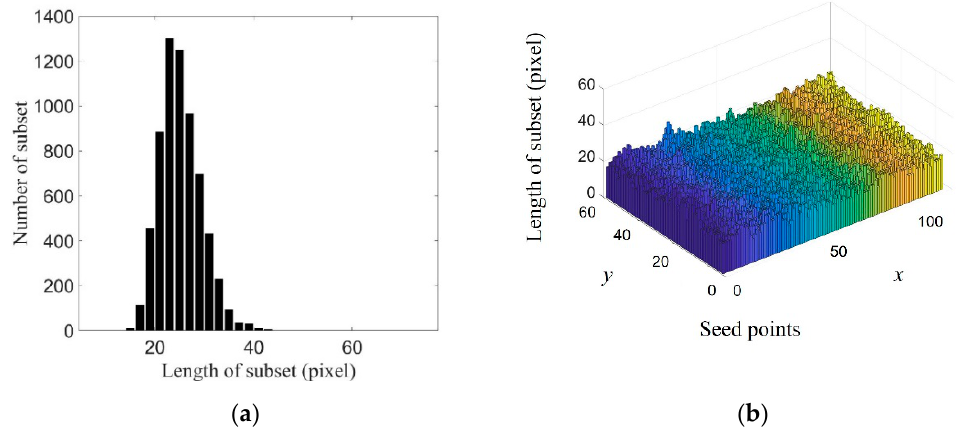
Figure 9. Determination results of adaptive subset sizes: ( a ) the number of adaptive subset sizes according to the subset length and ( b ) spatial distribution of the adaptive subset sizes.